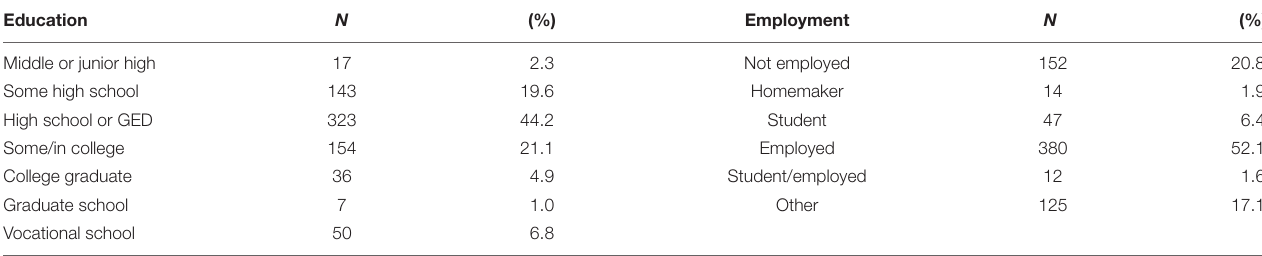
TABLE 4 | Self-reported education and